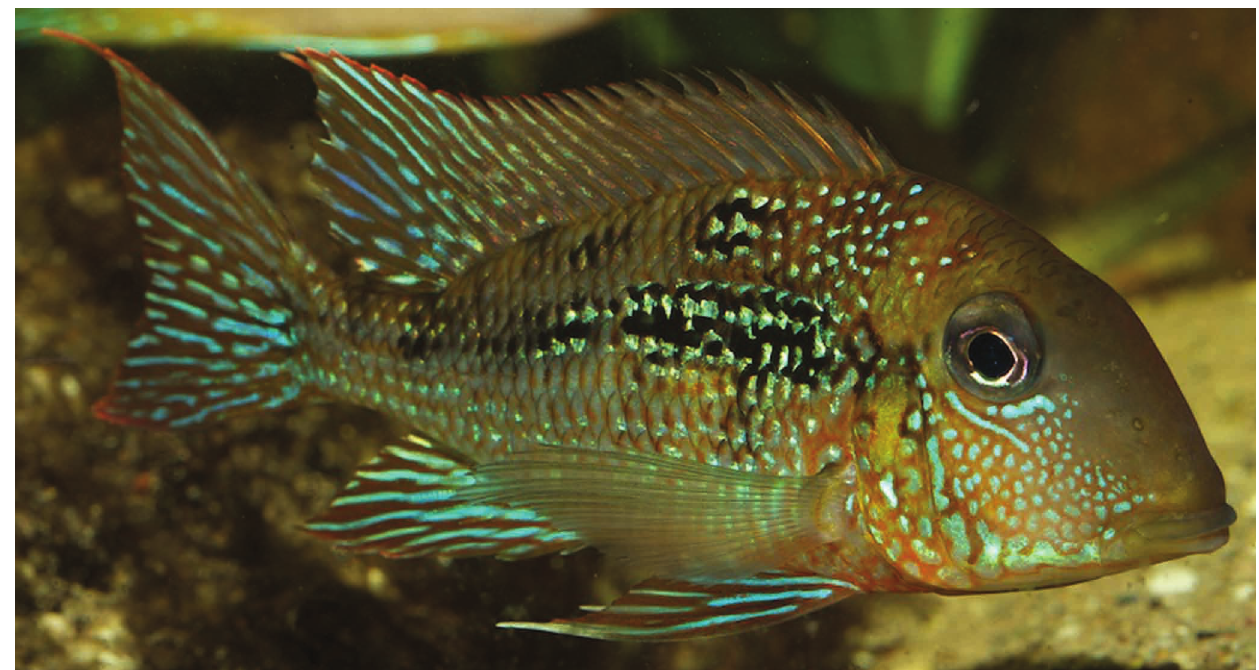
Fig. 5. Geophagus mirabilis , living specimen in aquarium, not preserved. Photograph by Oliver Lucanus.